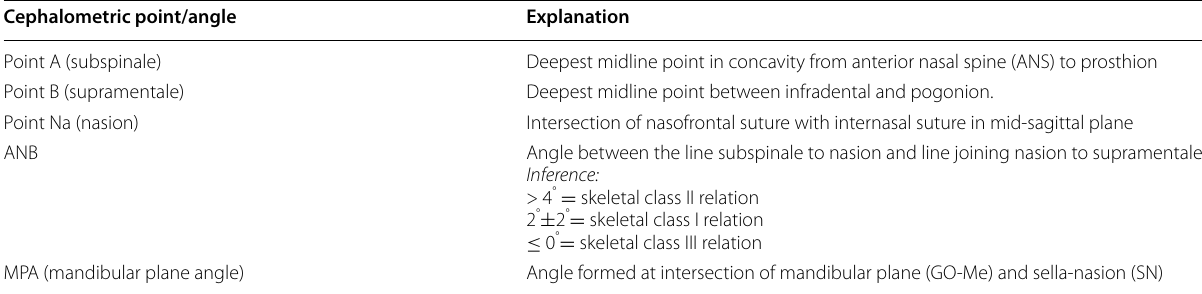
Table 2 Cephalometric points for sagittal and vertical skeletal jaw arrangement (Chalala et al. 2019; Rana et al. 2012) Cephalometric